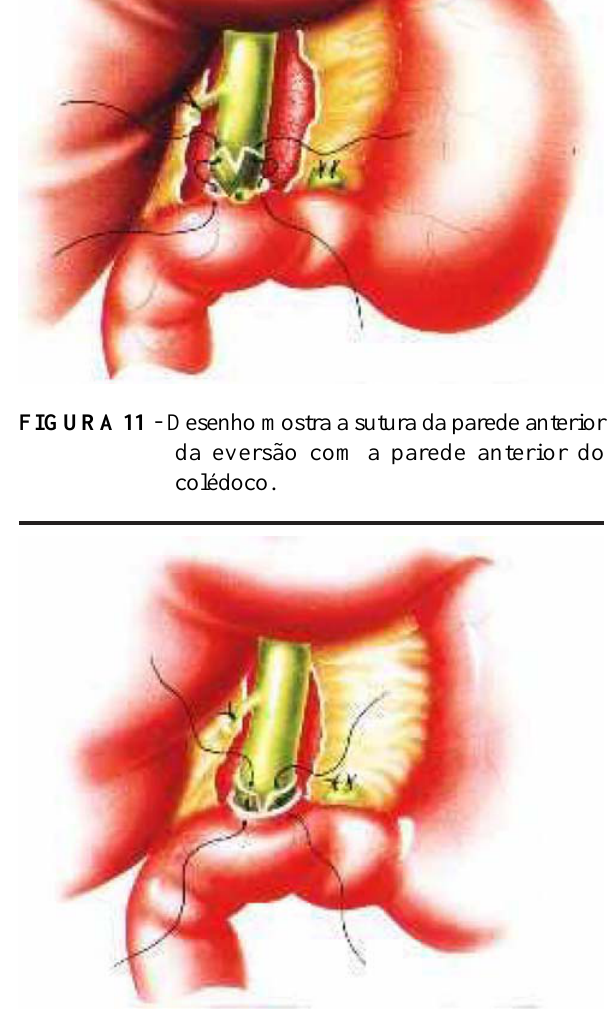
FIGURA 12 - Desenho mostra a porção evertida do colédoco sendo introduzida no